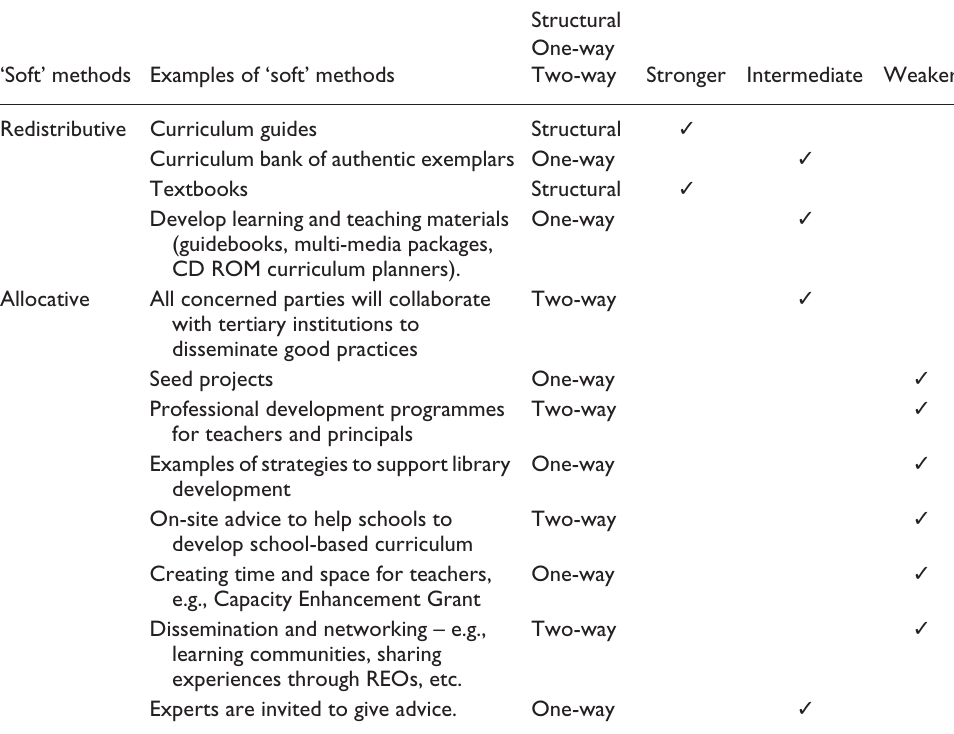
Table 3. ‘Soft’ methods used in the ‘ Learning to learn ’ reform.